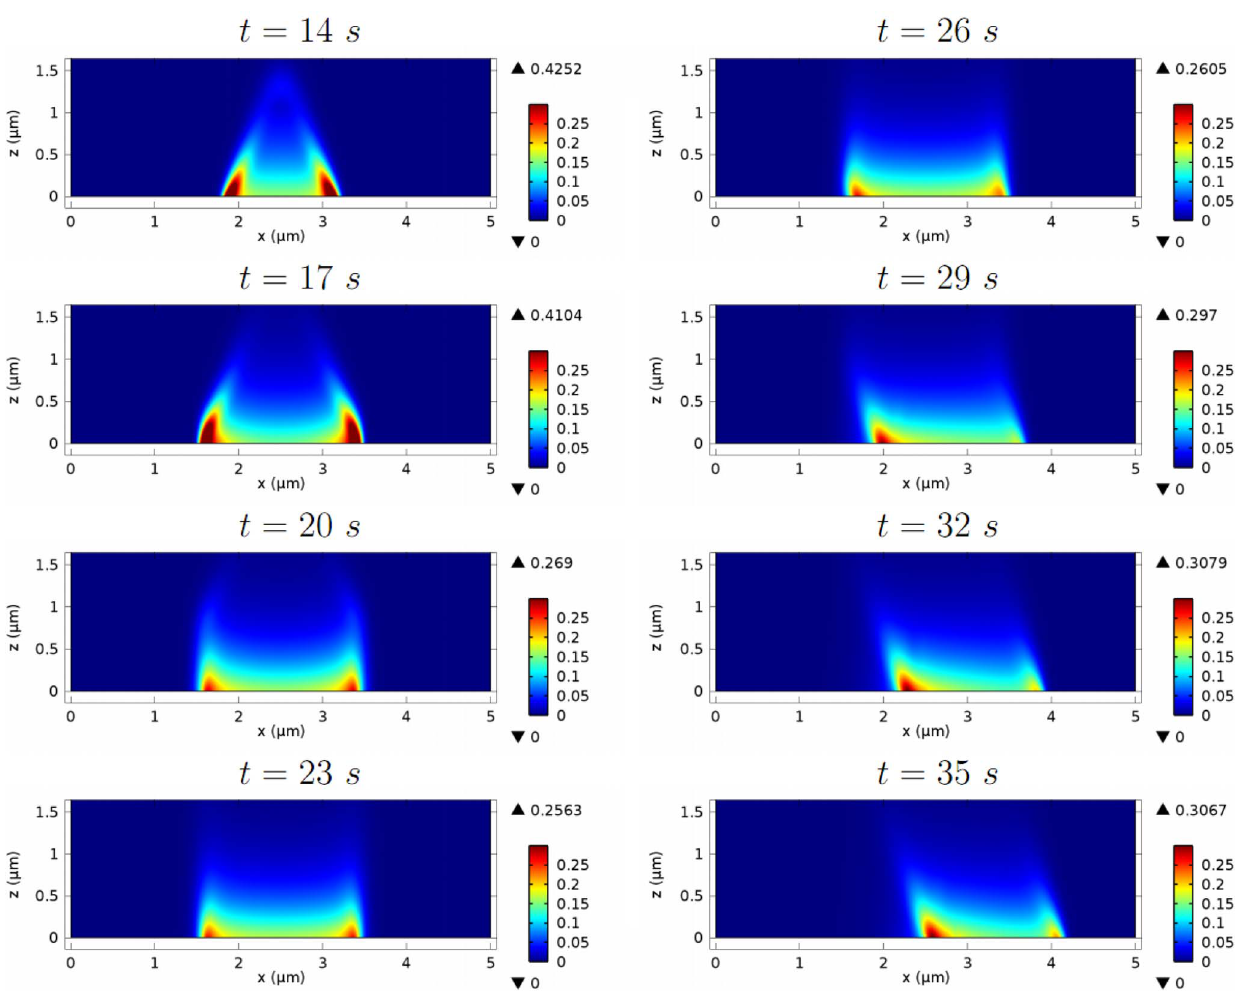
Figure 15. Standing and retracting actin waves. The surface density of pointed ends (in m M ) at a sequence of times. The actin waves stall between 17 { 35 s , upon reaching the boundary of the PTEN region ( x v 1 : 5 m m and x w 3 : 5 m m ) . The PTEN region is stationary for t v 25 s and then translates to the right at a speed of 0 : 1 m m = s , causing the wave to retract at the left and advance at the right.